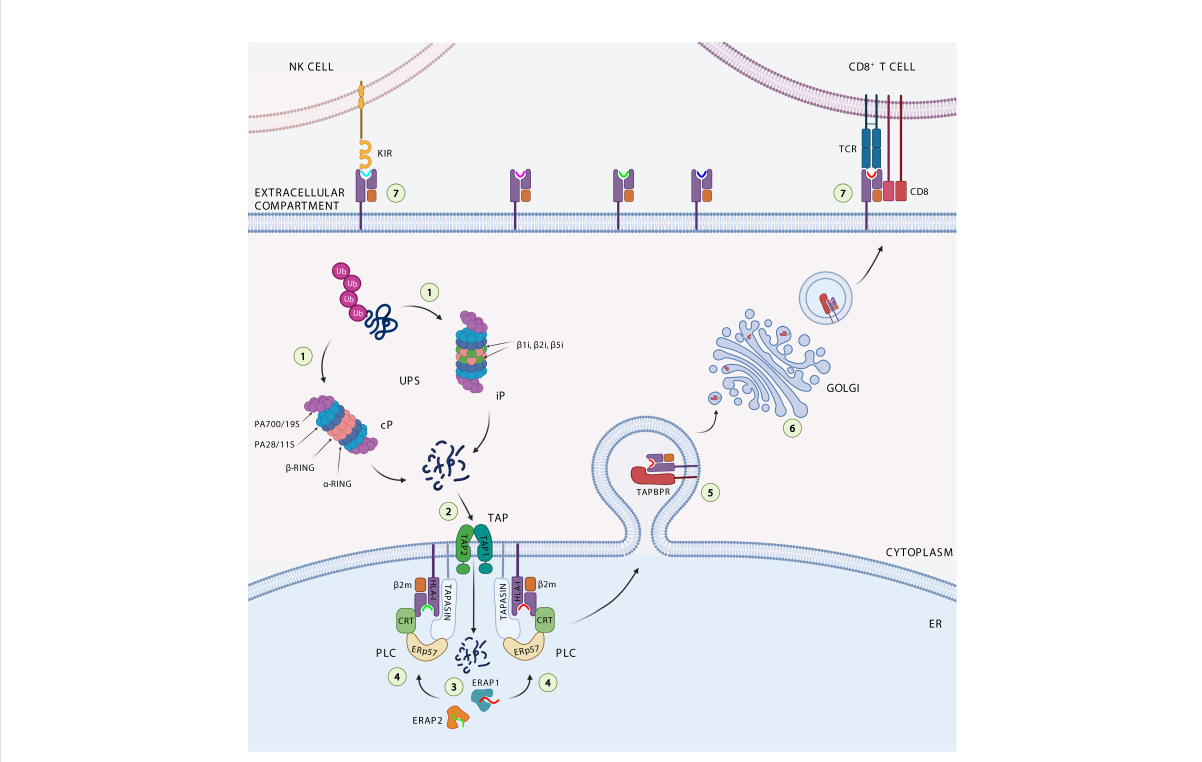
FIGURE 1 Antigen processing and presentation pathway. The ubiquitinated proteins are degraded (1) by the catalytic subunits of the constitutive proteasome (cP) or immunoproteasome (iP) into peptides. The peptides generated are translocated (2) through the transporter associated with antigen processing (TAP1 and TAP2) complex into the endoplasmic reticulum (ER), where they can be further trimmed (3) by the ER aminopeptidases ERAP1 and ERAP2. Loading onto the HLA class I heavy chain-associated b 2-microglobulin ( b 2m) (4) is a multistep process facilitated by the peptide loading complex (PLC), composed of TAP, ERp57, and the chaperones tapasin and calreticulin (CRT). Binding of high- af fi nity peptide induces dissociation of the HLA class I complex from PLC, its stabilization by interaction with TAP-binding protein related (TAPBPR) (5), and subsequent traf fi cking (6) to the cell surface to be presented to cytotoxic CD8 + T cells and NK cells